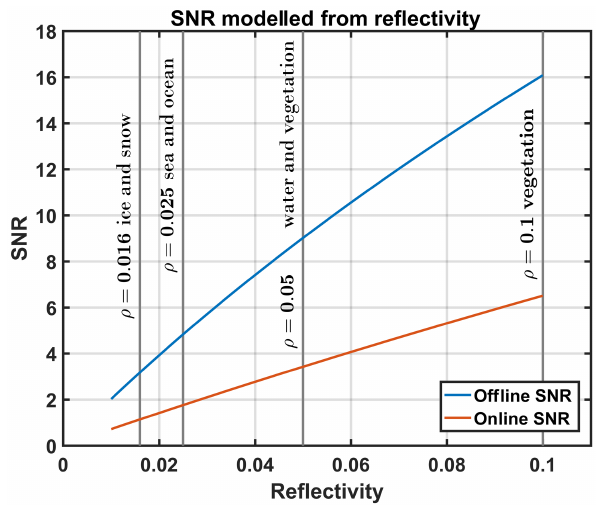
Figure 9. Online and offline SNR computed from reflectivity ac- cording to instrument